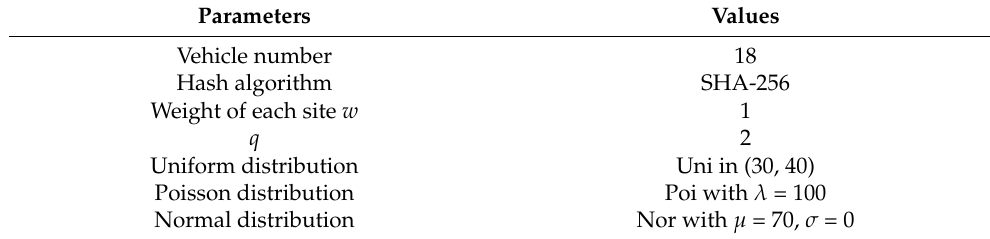
Table 2. The Main Parameters. Parameters Values Vehicle number 18 Hash algorithm SHA-256 Weight of each site w 1 q 2 Uniform distribution Uni in (30, 40) Poisson distribution Poi with λ = 100 Normal distribution Nor with µ = 70, σ = 0